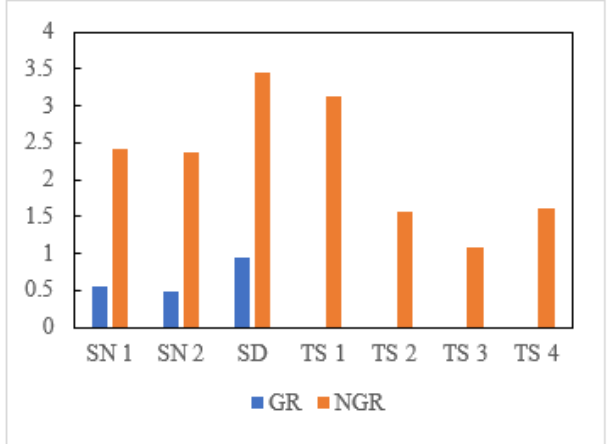
Figure 7. Comparison of GR and NGR.